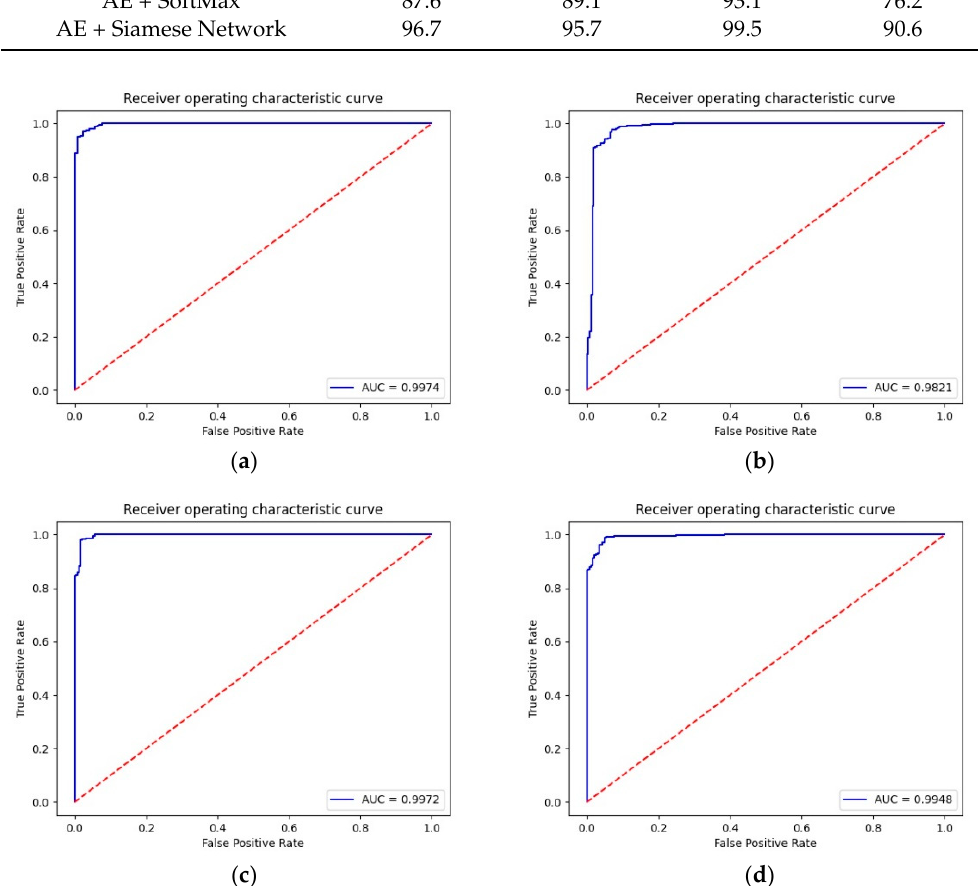
Figure 10. This figure is ROC curves of our model at different magnification images: ( a ) ROC of 40× magnification images; ( b ) ROC of 100× magnification images; ( c ) ROC of 200× magnification images; ( d ) ROC of 400× magnification images. The ROC curve analysis showed that the AUCs of the proposed model ranged from 0.982 ~ 0.997 for different magnification factors, indicating the effectiveness of the framework.